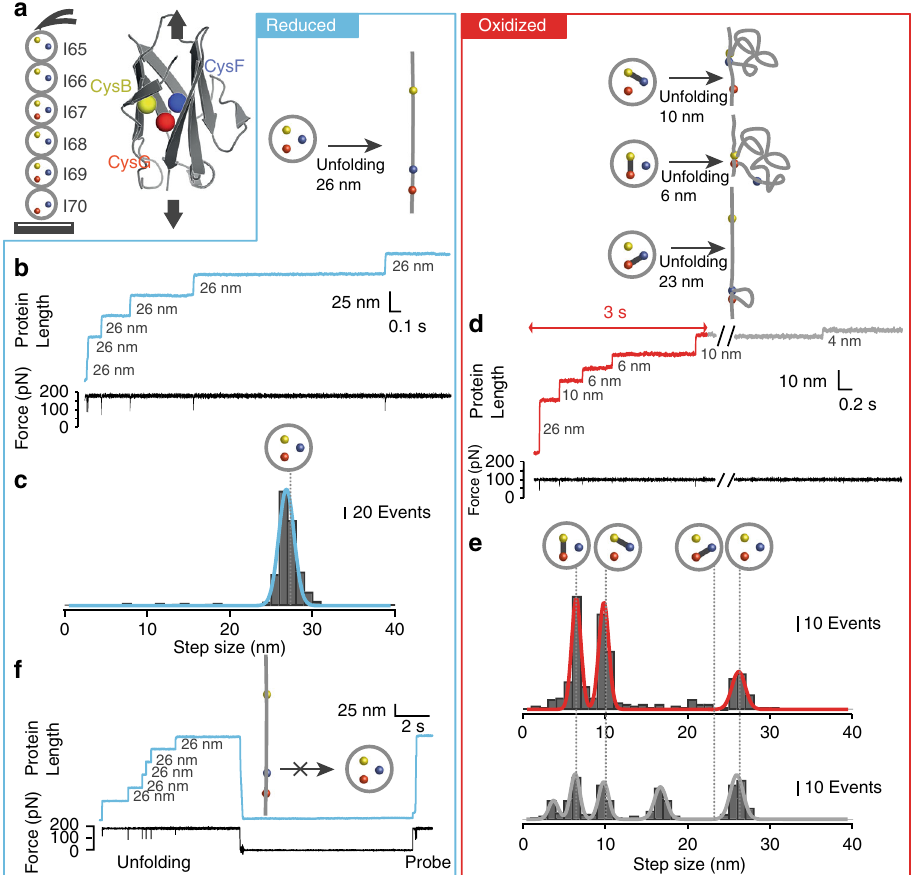
Fig. 2 Disul fi de bonds in I65 – I70. a Schematic representation of cysteine position in the six Ig domains composing I65 – I70, and X-ray structure of I67 (pdb: 3B43) with arrows representing the applied force at the termini in AFM experiments. CysB, CysF and CysG are highlighted. Step sizes are indicated